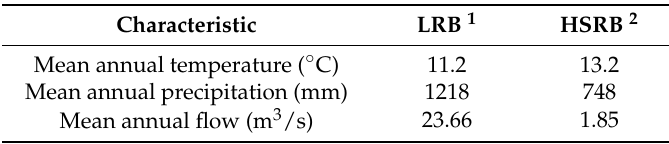
Figure 1. ( a ) Location of the Miño-Sil and Segura River Basins in Peninsular Spain; ( b ) Location of the LRB in the Miño-Sil River Basin; ( c ) Location of the HSRB in the Segura River Basin; ( d ) DEM of the LRB; ( e ) DEM of the HSRB. Table 1. Characteristics of the watersheds.